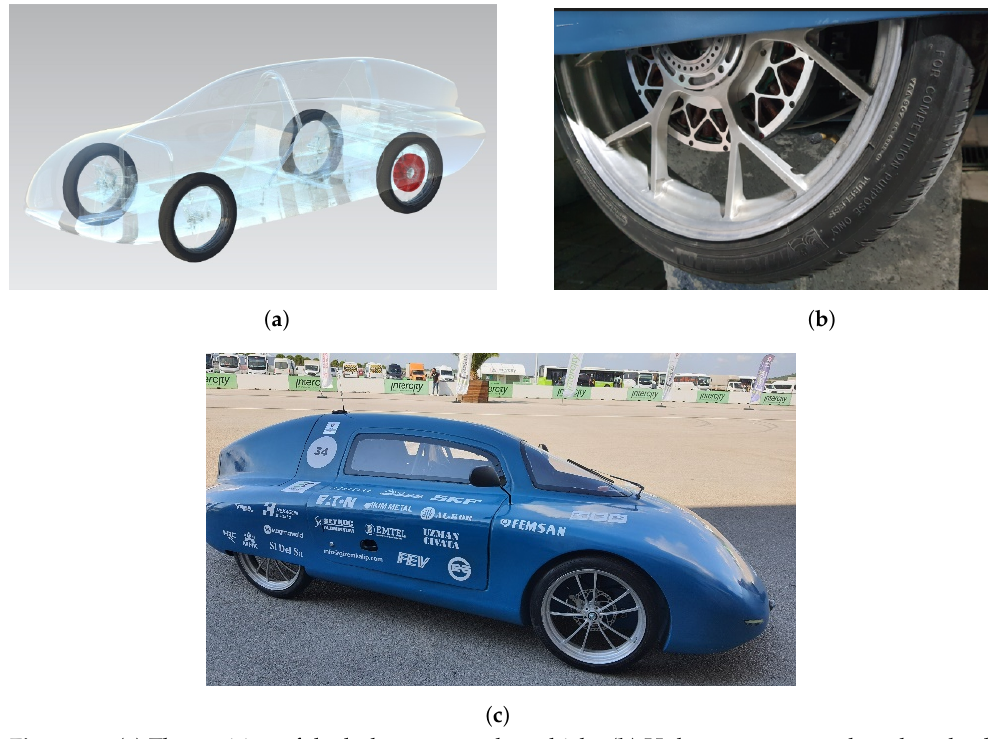
Figure 25. ( a ) The position of the hub motor on the vehicle. ( b ) Hub motor mounted on the wheel. ( c ) Light electric race car with the prototyped